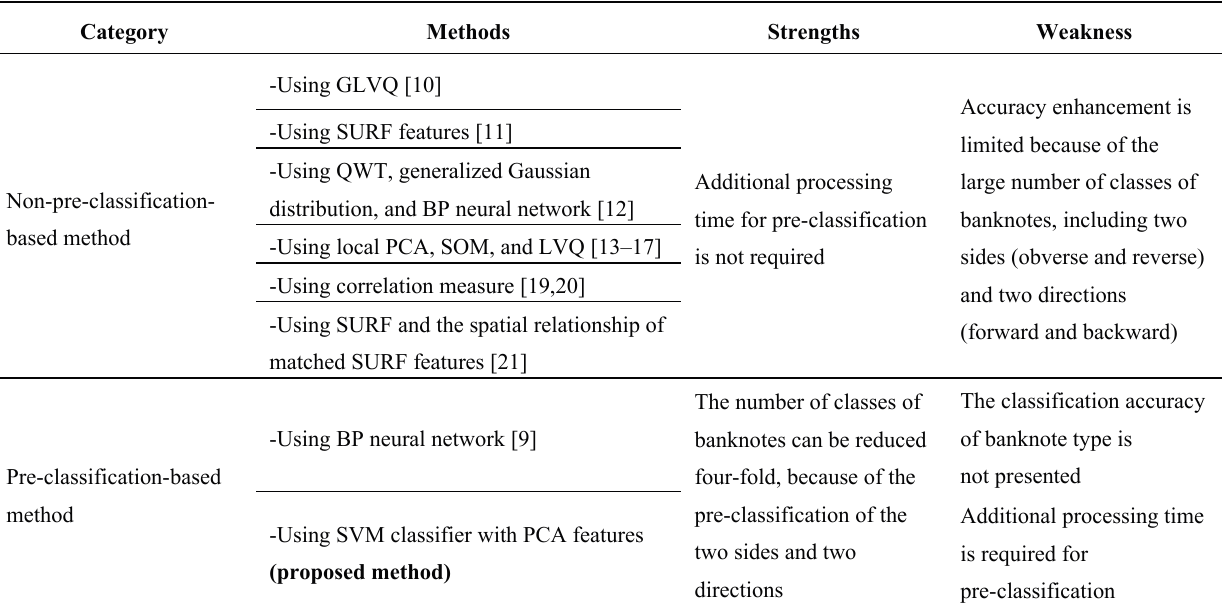
Table 1. Comparison of the proposed method with previous